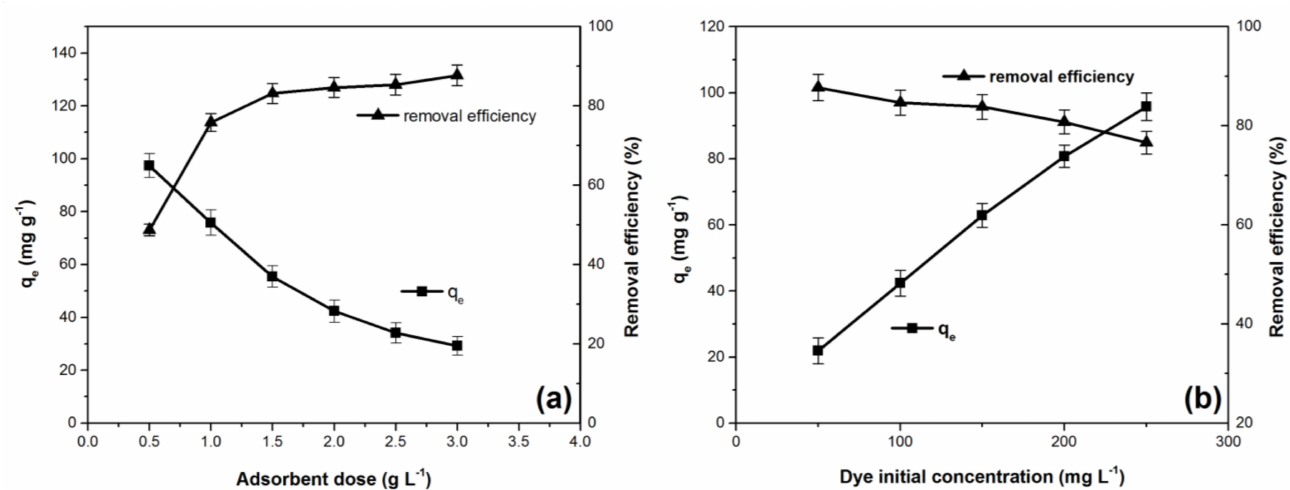
Figure 4. Effect of adsorbent dose ( a ) and initial dye concentration ( b ) on adsorption capacity and removal efficiency for the crystal violet adsorption onto Bathurst burr powder [adsorption conditions: ( a ): pH 7; initial dye concentration: 100 mg · L − 1 ; contact time: 30 min; temperature: 294 K, ionic strength: 0 mol L − 1 ( b ): pH 7, contact time: 30 min; adsorbent dose: 2 g · L − 1 ; temperature: 294 K; ionic strength: 0 mol L − 1